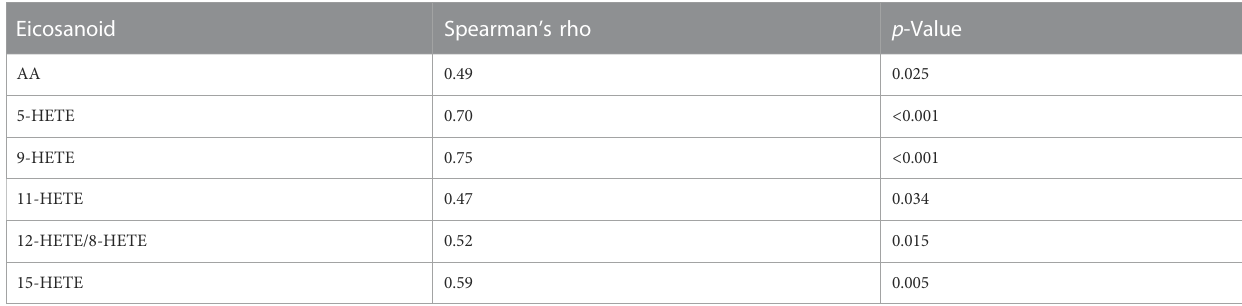
TABLE 2 Correlations between storage duration and normalized abundance of